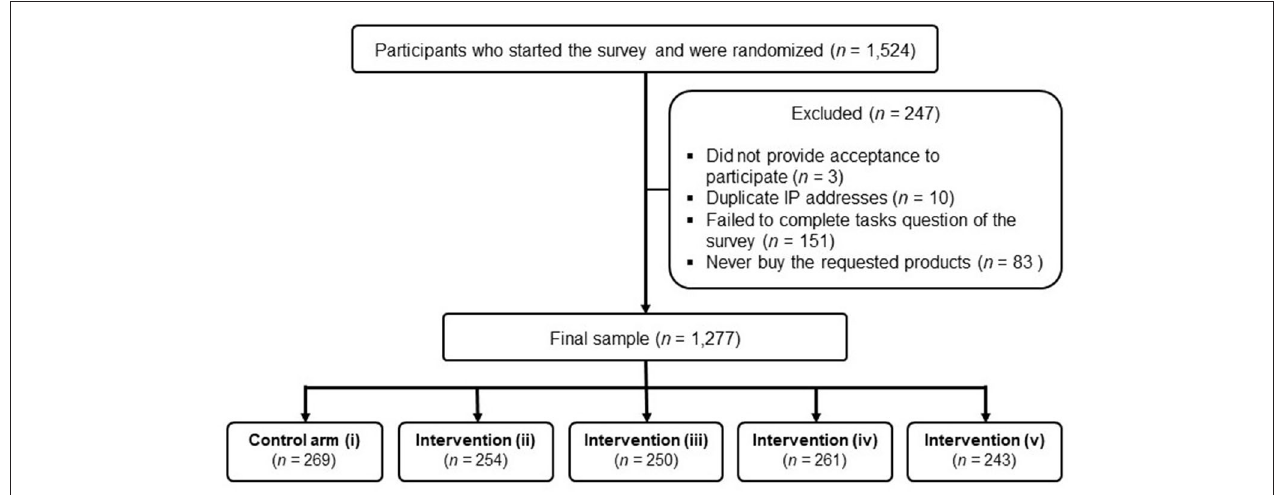
FIGURE 2 | Flowchart of the participants included in the